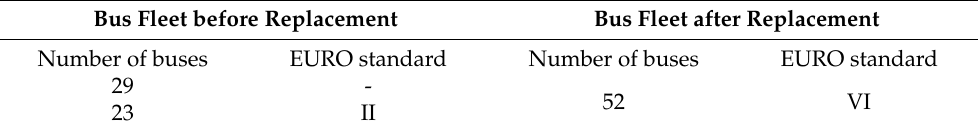
Table 1. The list of the bus fleet before replacement (left side) with the new replaced buses (right side), including basic parameters, such as the number and EURO standard, input to COPERT. Bus Fleet before Replacement Bus Fleet after Replacement Number of buses EURO standard Number of buses EURO standard 29 - 52 VI 23 II